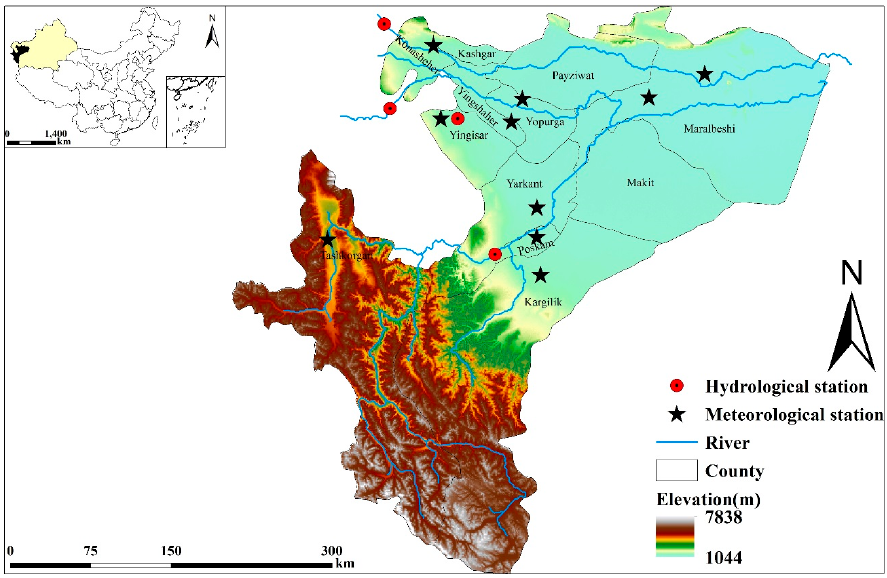
Figure 1. Location map of study area.